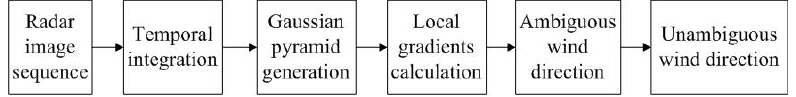
Figure 2. Scheme of the local gradients method (LGM) for wind direction